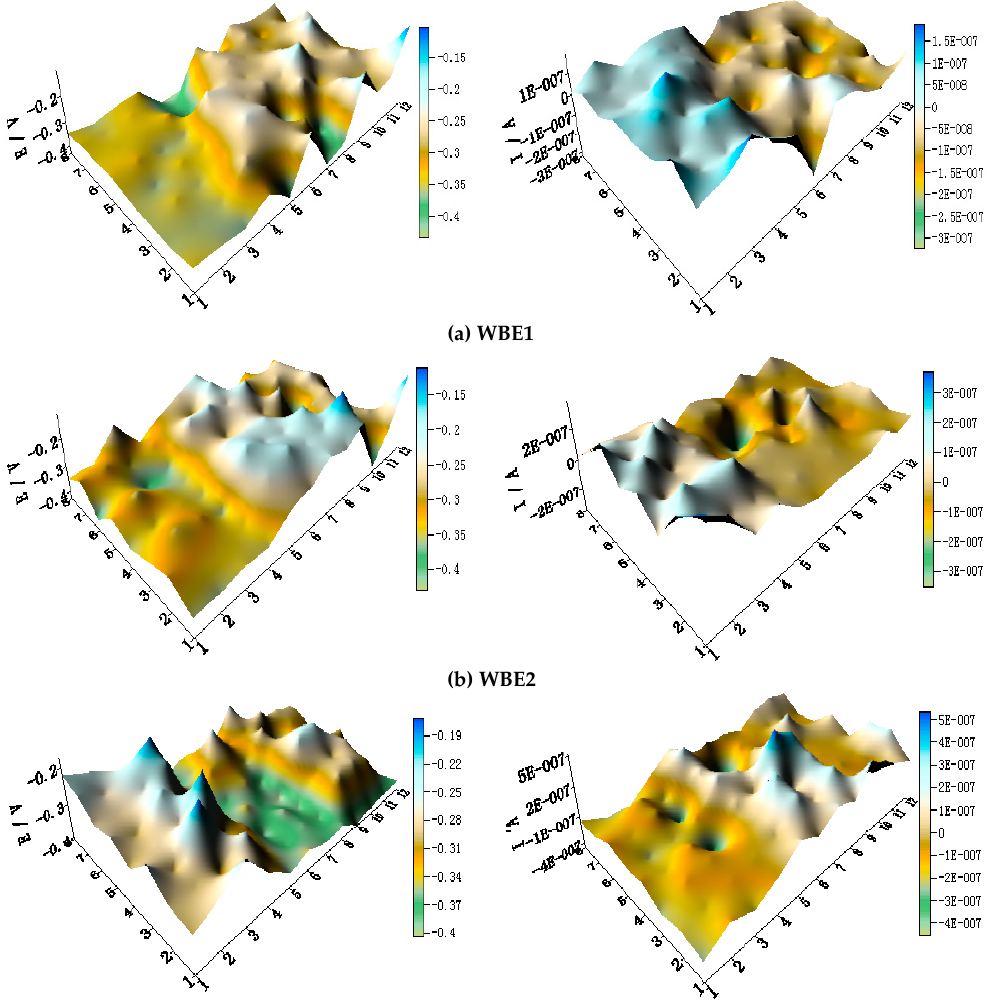
Figure 17. Spatial potential (left, E vs. SCE/V) and current–density (right, I/A) distribution maps of three coupled electrodes after being short-circuited for 12 h in artificial seawater with 1.5 wt % Cl − at 30 °C: ( a ) WBE1, HAl77-2/316L SS/TA2; ( b ) WBE2, HAl-77-2/TA2/316L SS; and ( c ) WBE3, TA2/HAl77-2/316L SS.